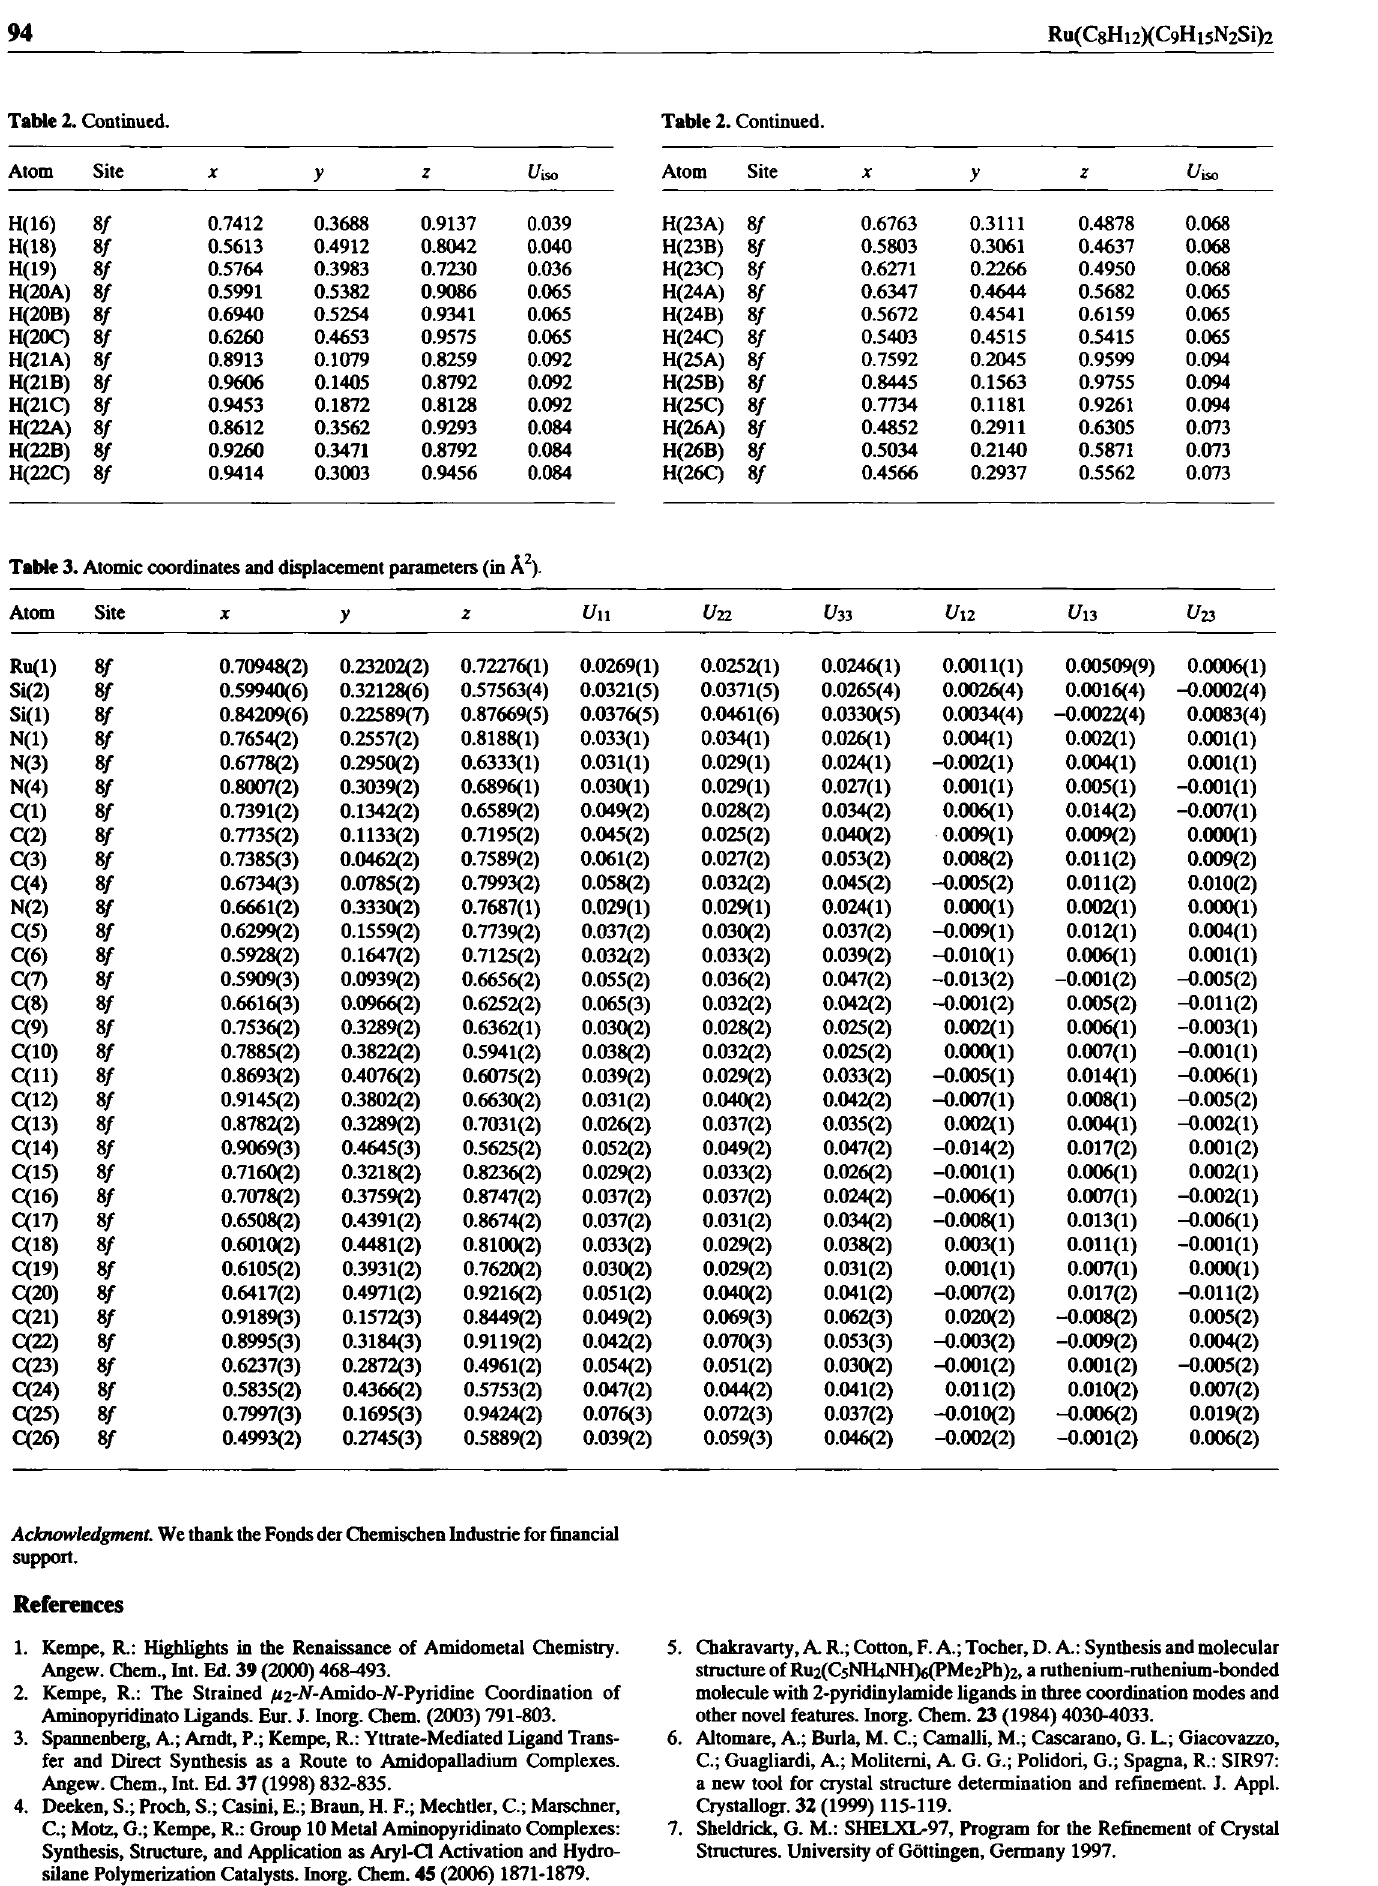
Table 3. Atomic coordinates and displacement parameters (in Ä 2